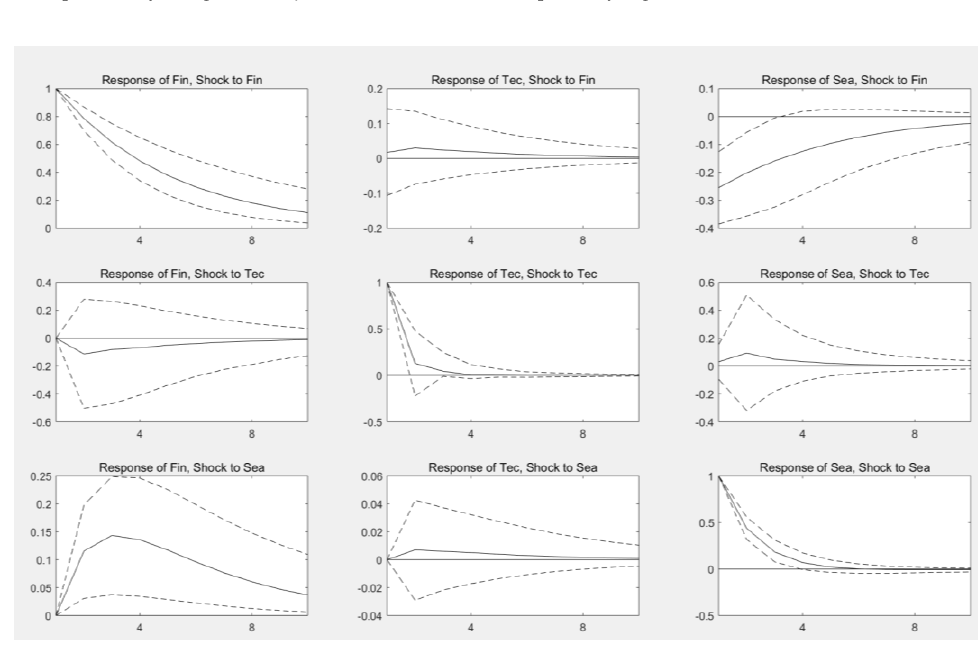
Figure 7. BVAR impulse response graph.